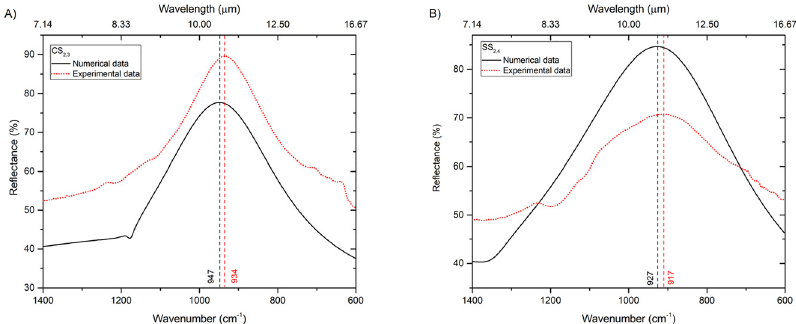
Figure 5: Comparison between simulated and experimental reflectance curves for naked NAs pixels (no molecules adsorbed). (A) Pixel CS 2,3 (L = 2.0 µm, P = 2.5 µm, W = 200 nm). (B) Pixel SS 2,4 (L = 2.0 µm, P = 2.5 µm, W = 110